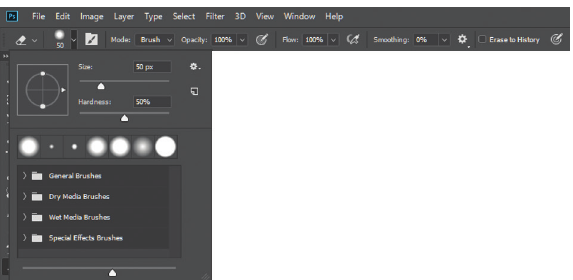
Figure 4. Options bar of a brush-type tool which can change the stroke size and hardness.